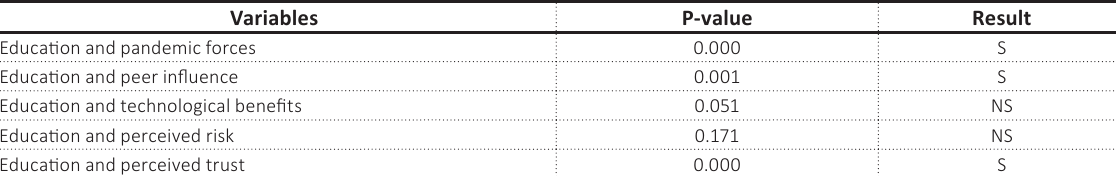
Table 6. Difference between education and the core